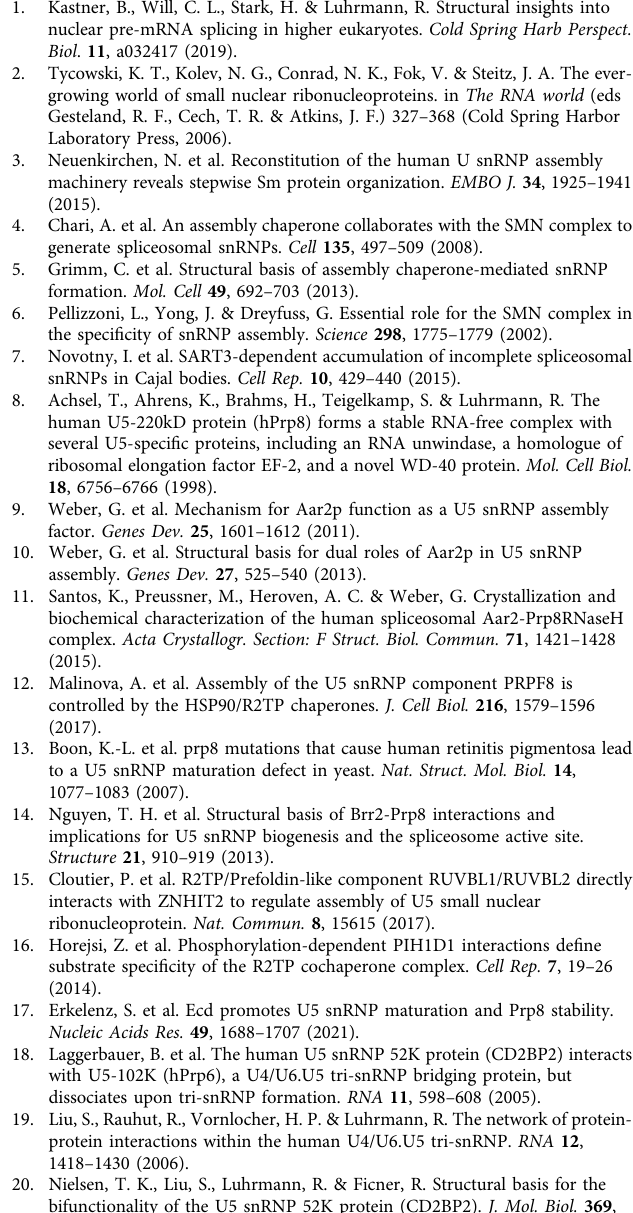
Supplementary Table 2. Splicing ef fi ciency (ratio pre-mRNA/mRNA) was calculated as [2 Ct(mRNA) – Ct(pre-mRNA) ]. For every experiment, two samples with different amounts of total RNA used (1 and 5µg) were analyzed and always the average of both values is presented. Yeast two-hybrid assay . Plasmids pACTII and pAS2 ΔΔ were introduced into haploid Saccharomyces cerevisiae strains (Y187 and CG1945, respectively). Strains were crossed and grown on YEPD and then plated on double- ( – Leu – Trp) and triple-selective media ( – Leu – Trp – His). Growth was assessed visually after 3 days at 30°C. The strength of interactions was evaluated by comparing the number of clones growing on – Leu – Trp (selection of diploids) and – Leu – Trp – His plates (selection for interaction). Growth was sometimes performed with a gradual concentration of 3-amino-1,2,4-Triazol (3-AT) which is a competitive inhibitor of the HIS3 gene